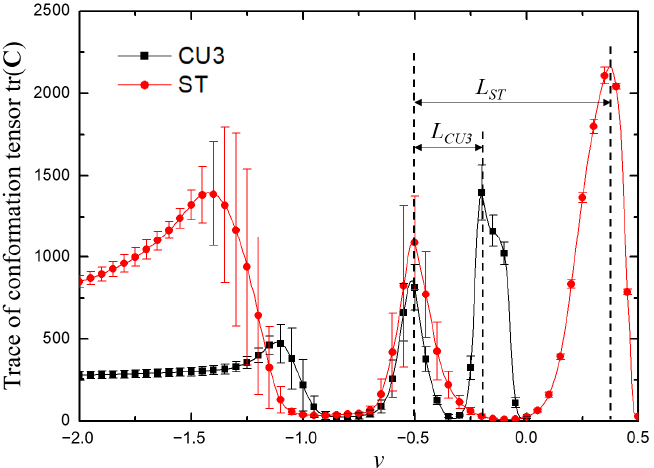
Figure 14. The time-averaged trace of conformation tensor tr( C ) changes at the line of x = − 0.4. For all cases, 𝛽 = 0.5 , Wi = 5 . L ST and L CU3 are the distance between the second and third maxima of tr( C ), which is a measure of the elastic effect in the junction domain for the cases of ST and CU3, respectively.